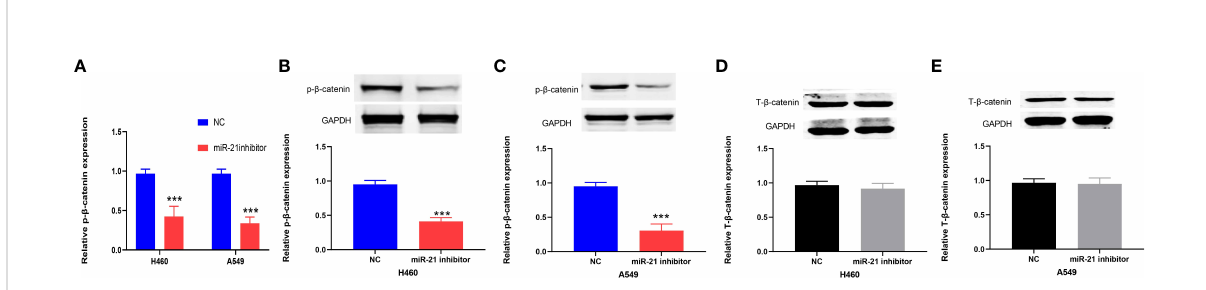
FIGURE 6 miR-21 is positively correlated with p- b -catenin but not T- b -catenin in lung cancer cells. (A – C) Western blot analysis of the expression of p- b - catenin in H460 and A549 cells treated with miR-21 inhibitor. (D, E) The expression level of T- b -catenin in H460 and A549 cells transfected with miR-21 inhibitor (*** p < 0.001).